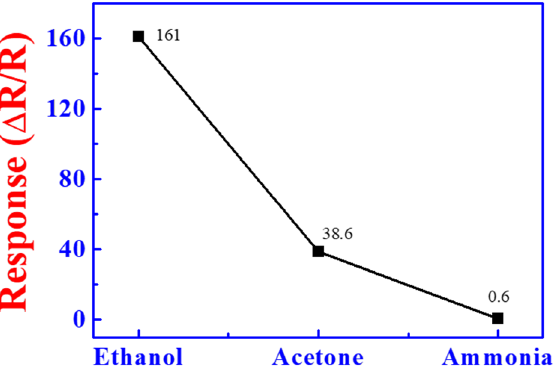
Figure 7. The selectivity of the APN device was exposed to three different gases (ethanol, acetone, and ammonia) under 10 ppm at 250 °C.